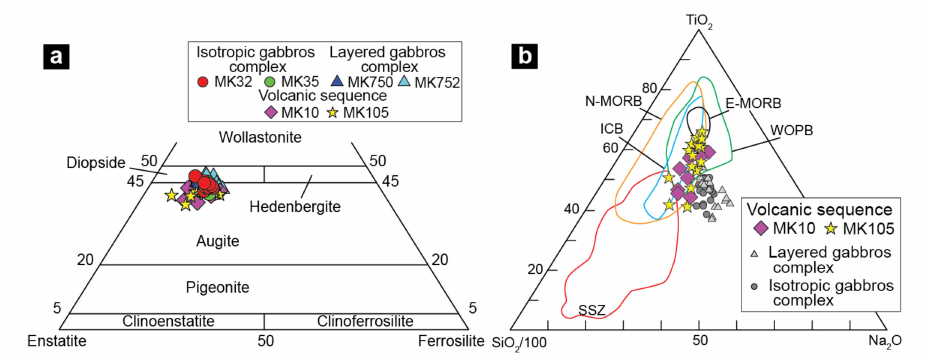
Figure 12. ( a ) Pyroxene quadrilateral diagram [81], and TiO 2 –Na 2 O–SiO 2 / 100 diagram for discriminating clinopyroxenes in basalts from di ff erent oceanic settings [82] ( b ). Clinopyroxene from the intrusive complex of Band-e-Zeyarat ophiolite are also plotted for comparison in ( b ). Abbreviations, E-MORB: enriched mid-ocean ridge basalt; N-MORB: normal mid-ocean ridge basalt; WOPB: within oceanic plate basalts; ICB: Iceland basalts; SSZ: supra-subduction zone